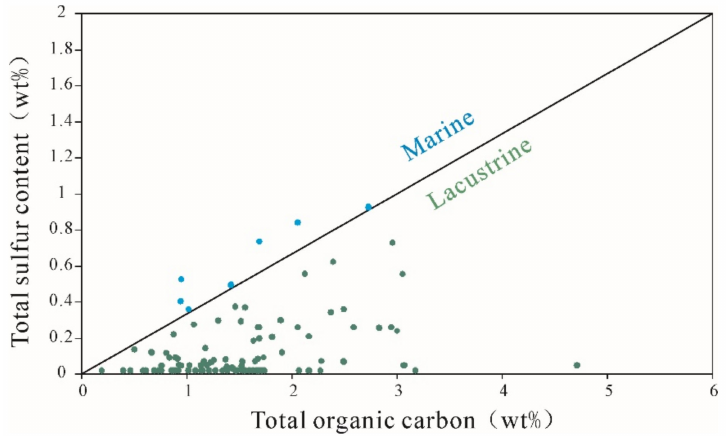
Figure 16. Total sulfur content versus TOC, adapted